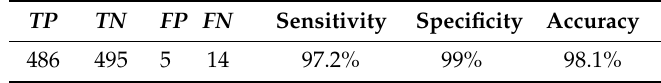
Table 7. Statistic for flooded area in images: 1000 pathces (500—flood, 500—non flood).